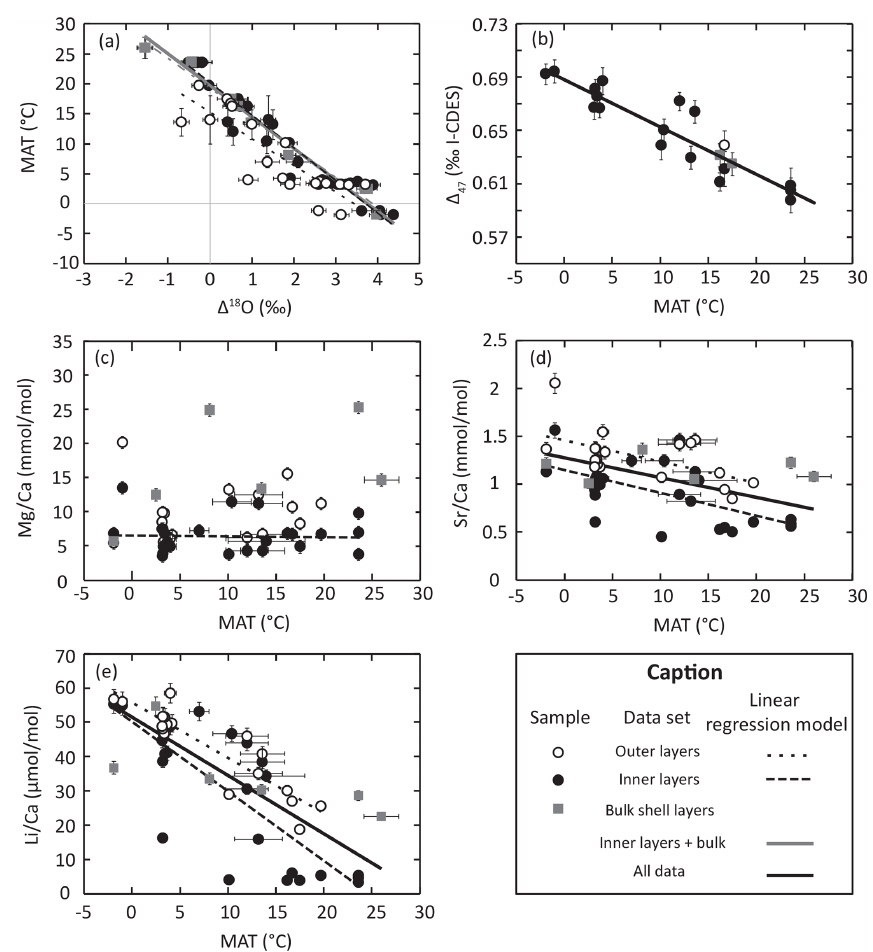
Figure 1. Geochemical data and linear regression model for each geochemical parameter tested for its relationship with brachiopod living temperature. Parameters associated with each regression model are listed in Table